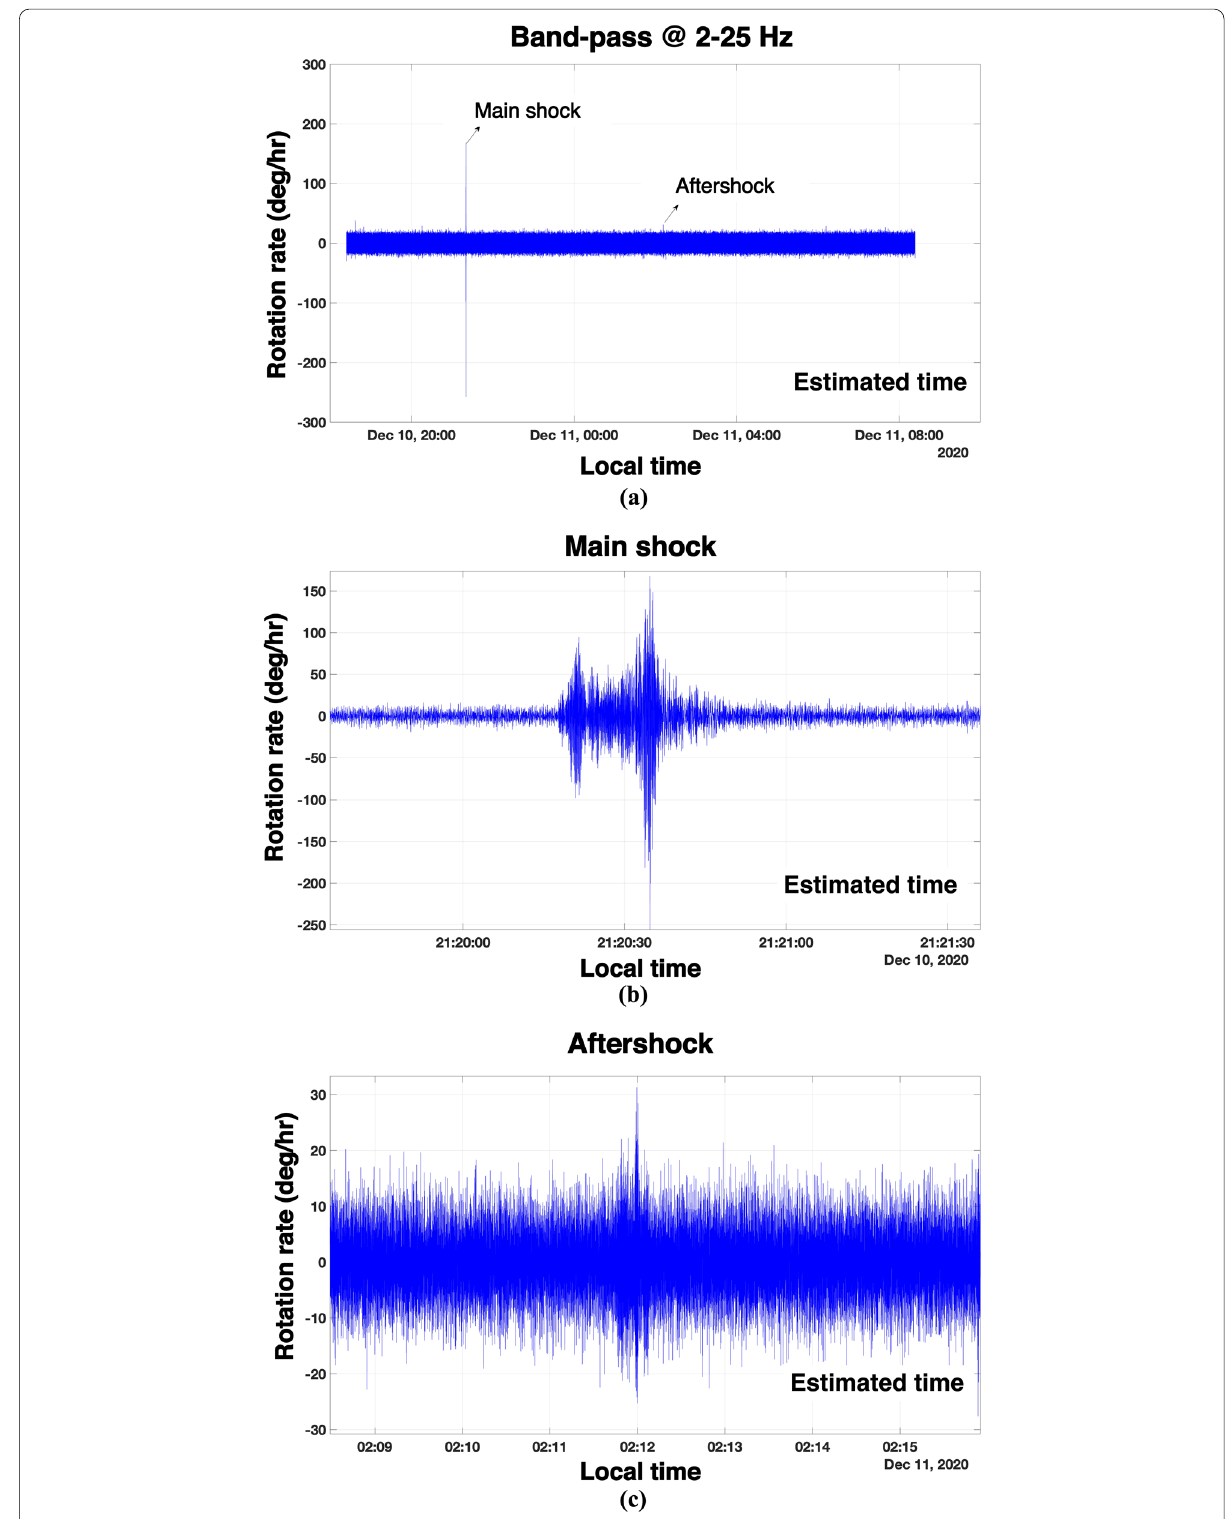
Fig. 8 5–30 Hz band‑pass filtered rotation rate information of the seismic waves recorded during the a 14‑h, b main‑shock, and c aftershock time